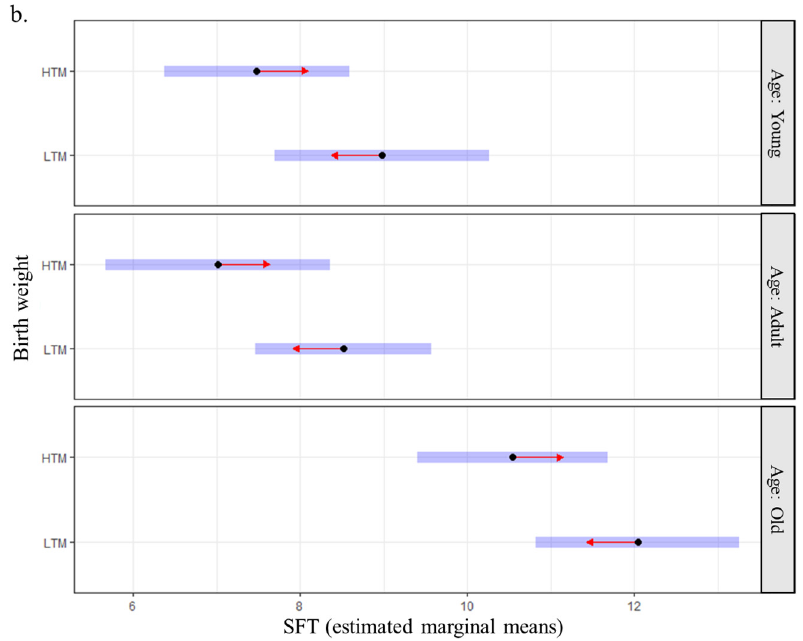
Figure 4. Relationship between birth weight and subcutaneous fat thickness at adulthood ( n = 88 Labradors) ( a ) by anatomical site and ( b ) by age. Note: Blue bars indicate confidence intervals for estimated marginal means of SFT. Overlapping between red arrows from two groups indicates a non-signi fi cant di ff erence between the two groups; HTM: higher than the median; LTM: lower than the median .